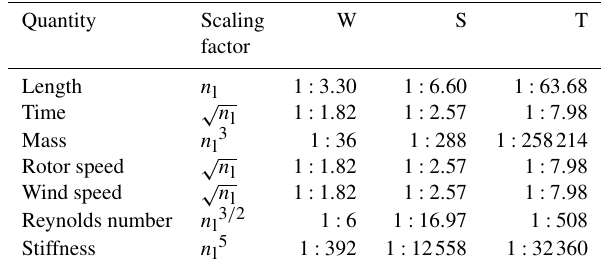
Table 4. Main structural characteristics of the blade of the 10MW machine.